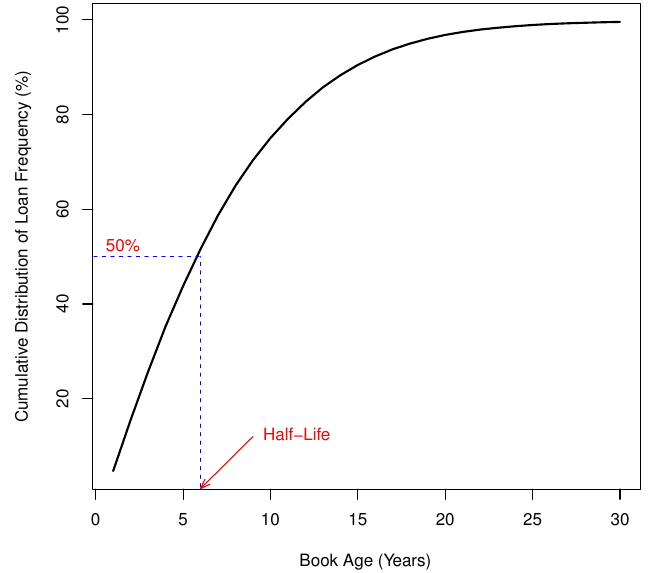
Figure 5. Cumulative distribution of loan frequency with respect to book age, where the half-life is